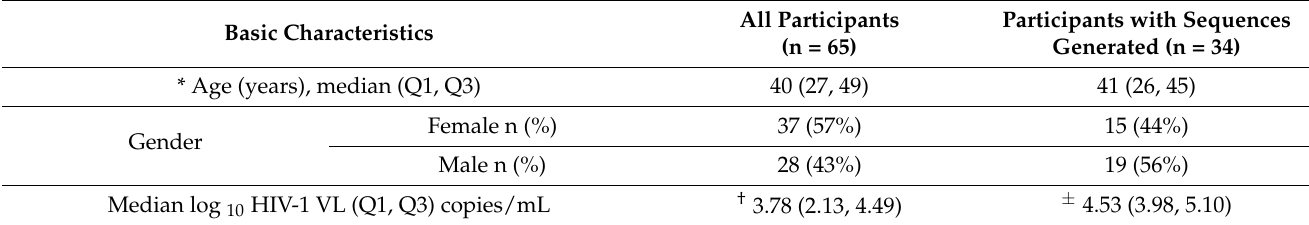
Figure 1. Flow diagram revealing the number of plasma, sequences and patients on various cART regimens. Seqs, sequences; DTG, dolutegravir; RAL, raltegravir, cART, combination antiretroviral therapy; INSTI, integrase strand transfer inhibitors. VS-Int, ViroSeq TM HIV-1 Integrase RUO Geno- typing kit Celera Corporation, USA; IH-Int, inhouse integrase assay. * Seqs clustering together with high bootstrap (>95) but being from different individuals. Table 1. Basic demographics and viral load characteristics of individuals failing DTG/RAL cART .